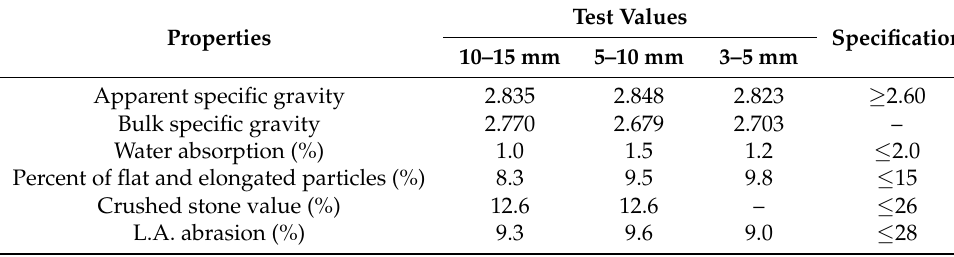
Table 1. Properties of the basalt coarse aggregates.